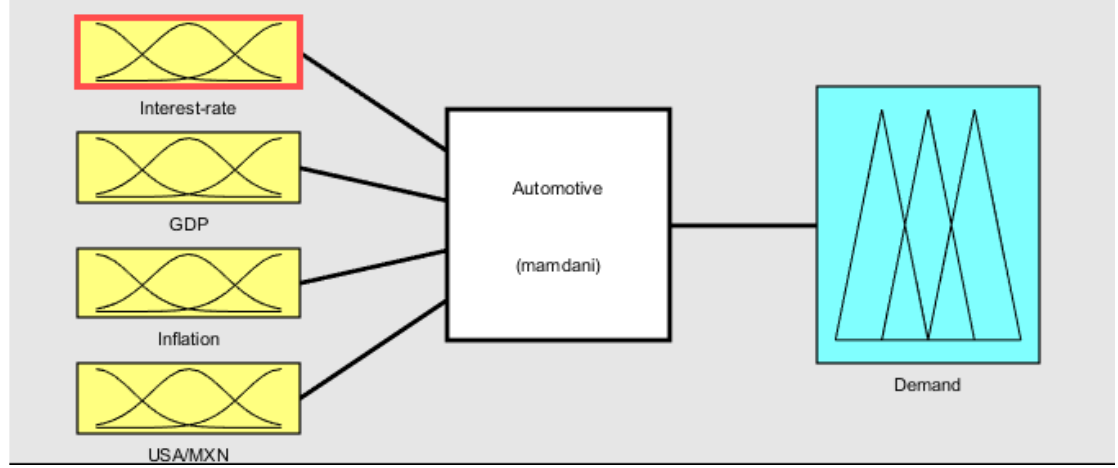
Figure 2. Fuzzy mechanism.